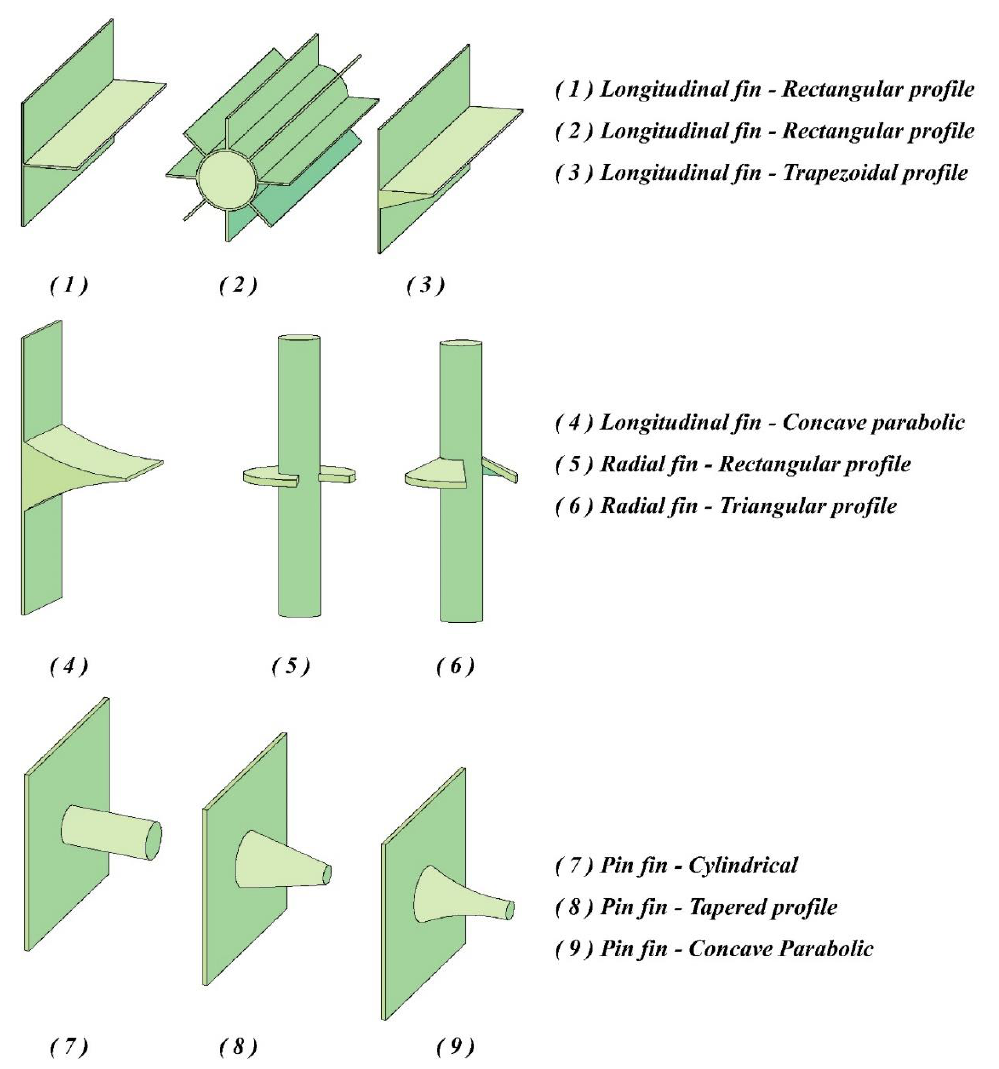
Figure 6. Some types of fins used in different enclosures [2].